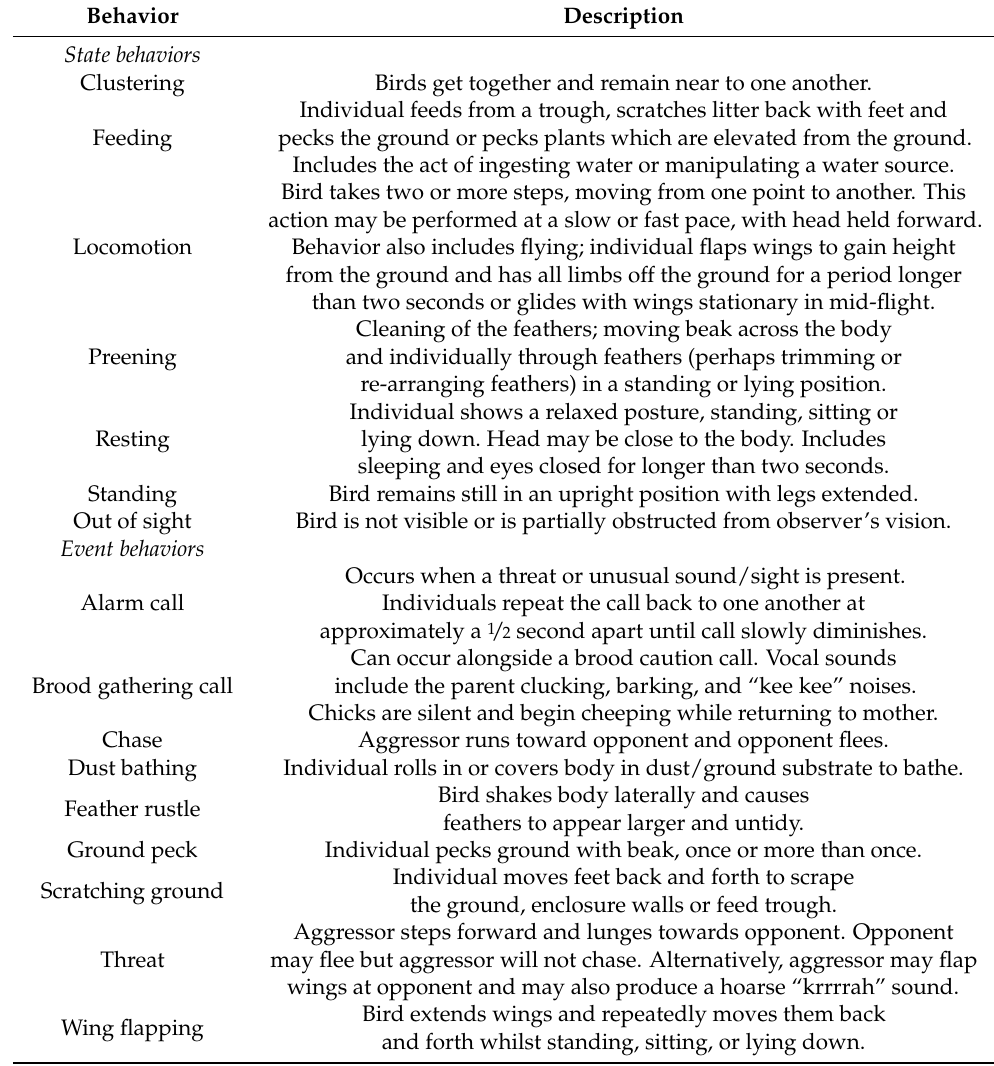
Table 2. L. edwardsi ethogram. Adapted from